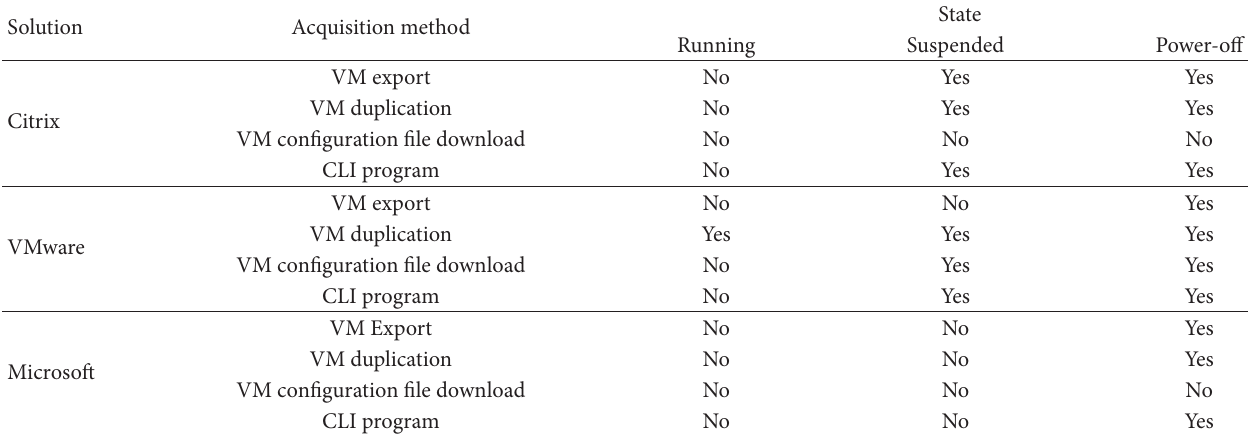
Table 10: Applicable acquisition method depending on the solution and state of the virtual machine.